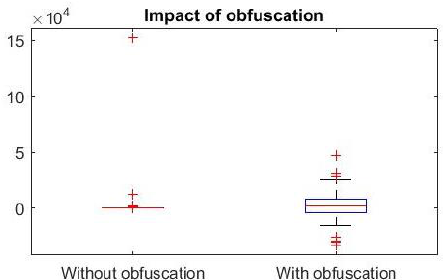
( a ) Impact of obfuscation on the distribution of 𝒻 1 feature values, shown by Box-Whisker plot. Figure 8. Cont